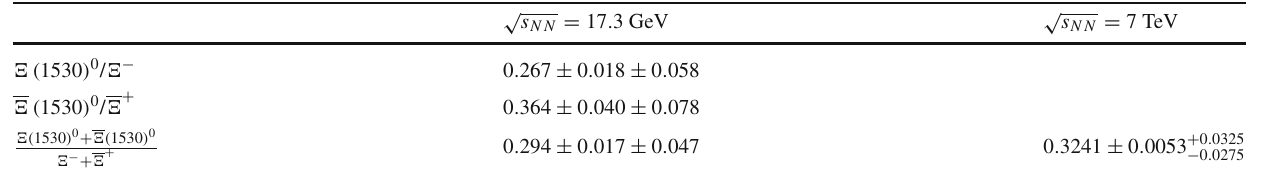
Table 4 The ratio of (cid:2)( 1530 ) 0 to (cid:2) − , of (cid:2)( 1530 ) 0 to (cid:2) ( (cid:2)( 1530 ) 0 + (cid:2)( 1530 ) 0 ) to ( (cid:2) − + (cid:2) tions at 17.3 GeV [12] and 7 TeV [2,11]. Systematic uncertainties were